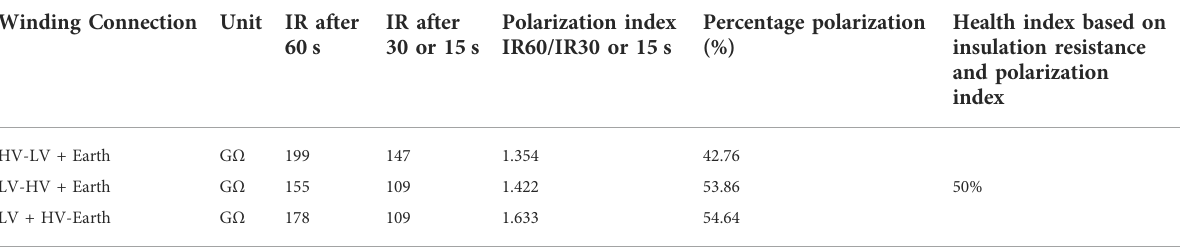
TABLE 6 Health index based on insulation resistance and polarization